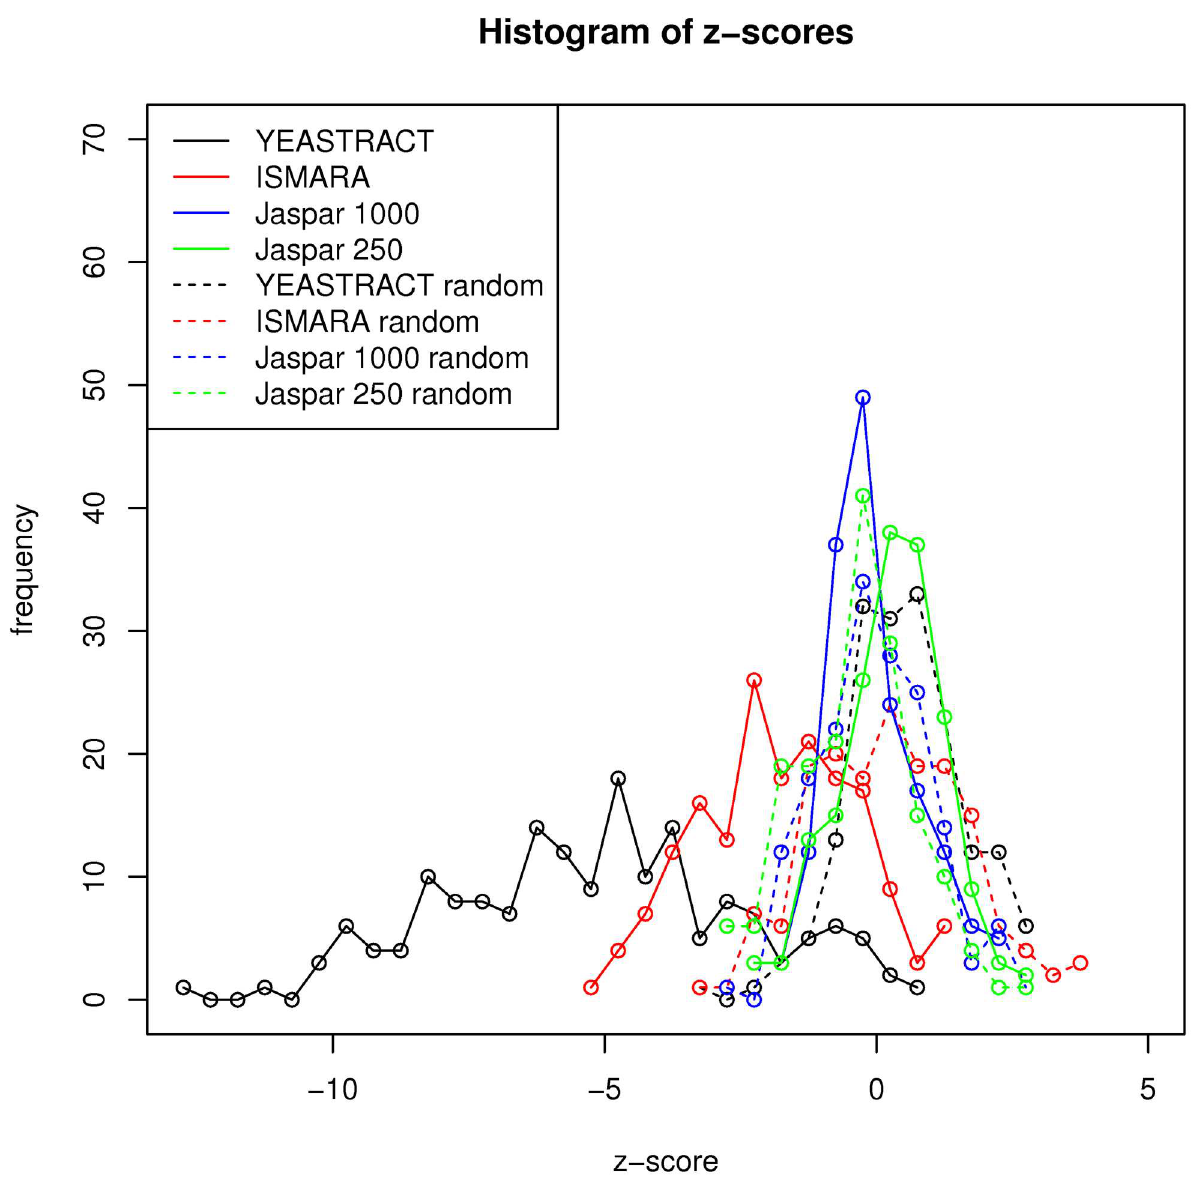
Fig 4. Z-score distributions of the comparison of the i-scores of the Act-A * solution for the real and randomized Gasch data. A negative z-score indicates that the i-score was smaller/better for the real data than for the randomizeddata. These z-scores were calculatedfor the YEASTRACT, ISMARA and Jaspar network and a random network with the same number of edges for each of these networks. When the YEASTRACT network is used the i-score is much better for the real than for the random data, whereas the scores are about the same for the Jaspar